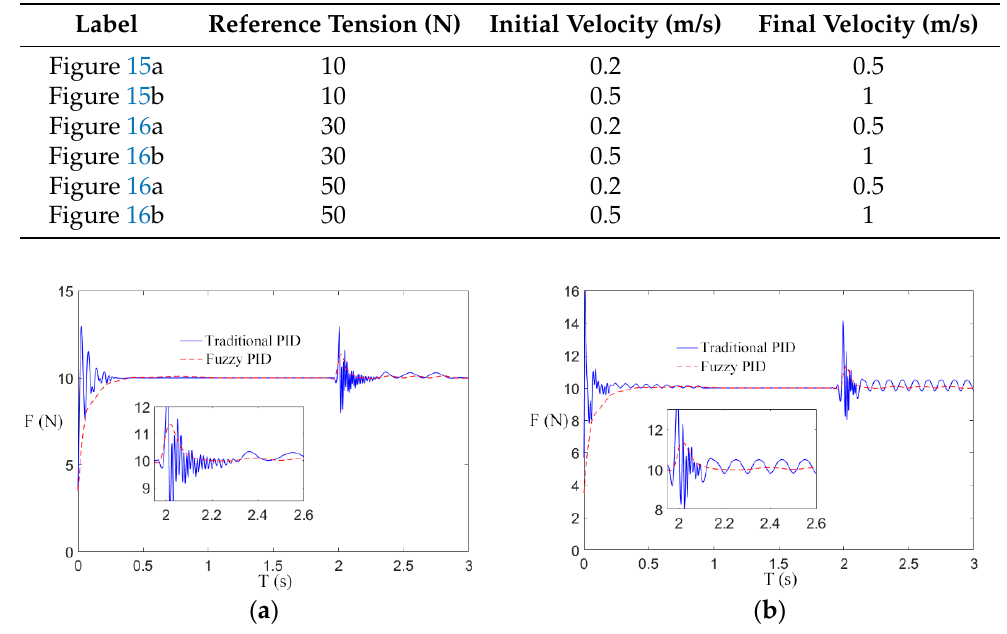
Figure 15. The influence of step when the reference tension is 10 N. ( a ) Situation 1; ( b ) Situation 2.